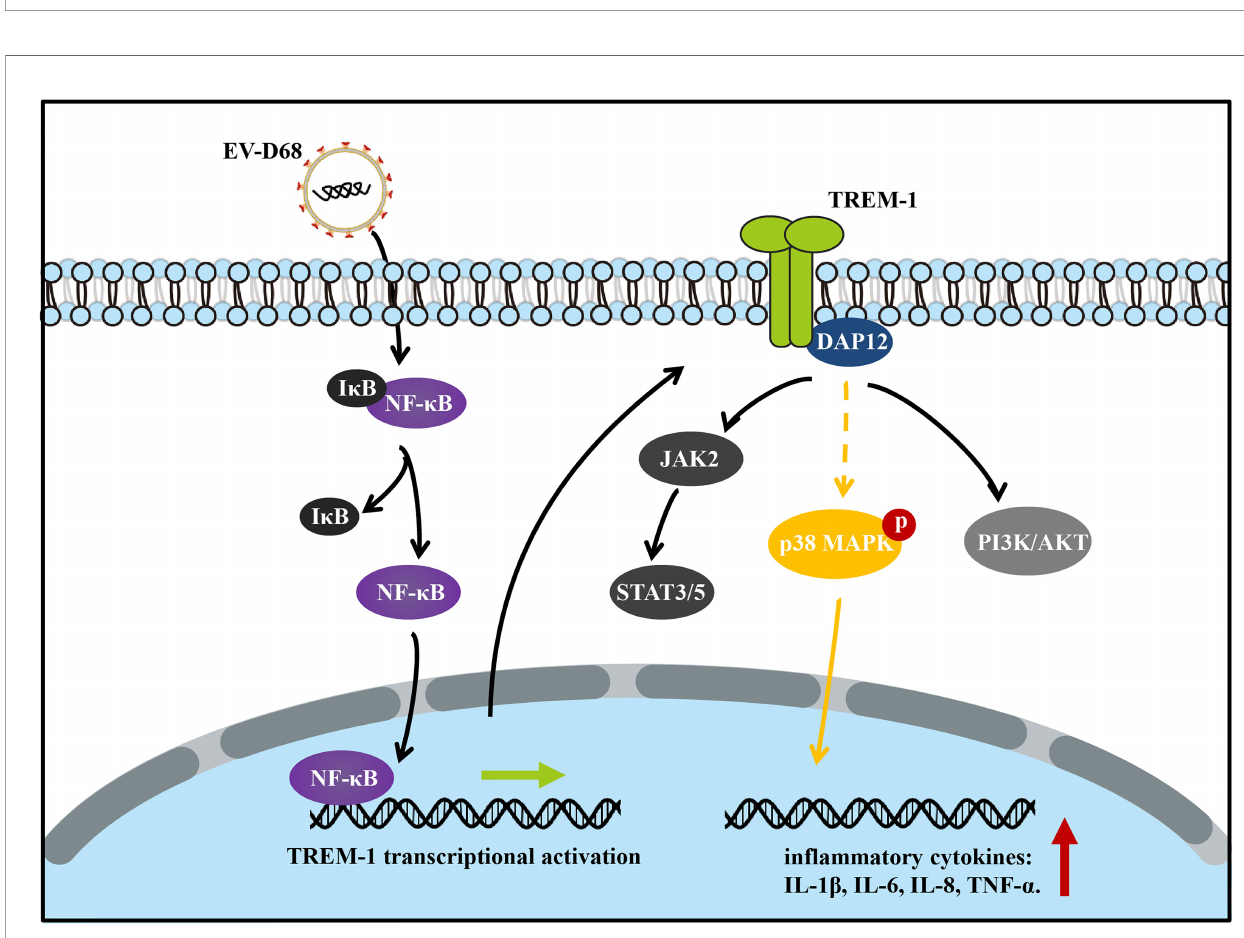
FIGURE 8 | Schematic diagram of the activated TREM-1 signal pathway during EV-D68 infection. Transcriptional activation of TREM-1 is induced by EV-D68, and TREM-1 then regulates the secretion of downstream cytokines including IL-6, IL-8, and TNF- a